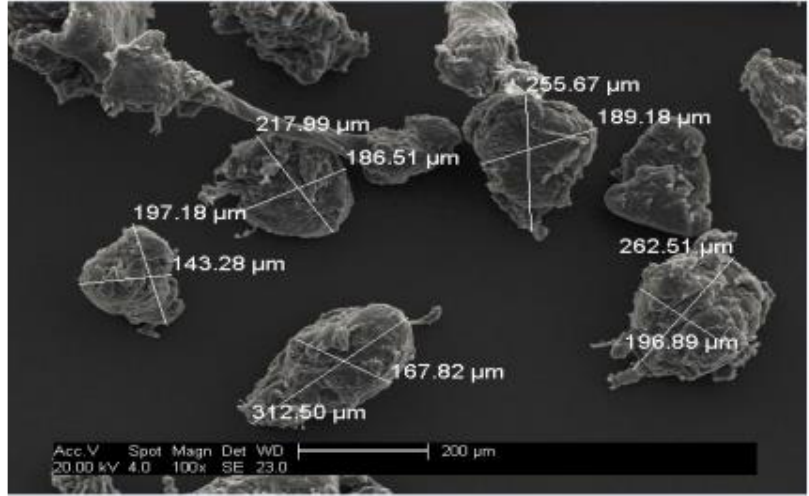
Figure 9. Microscopic image of the polyethylene particles [27].